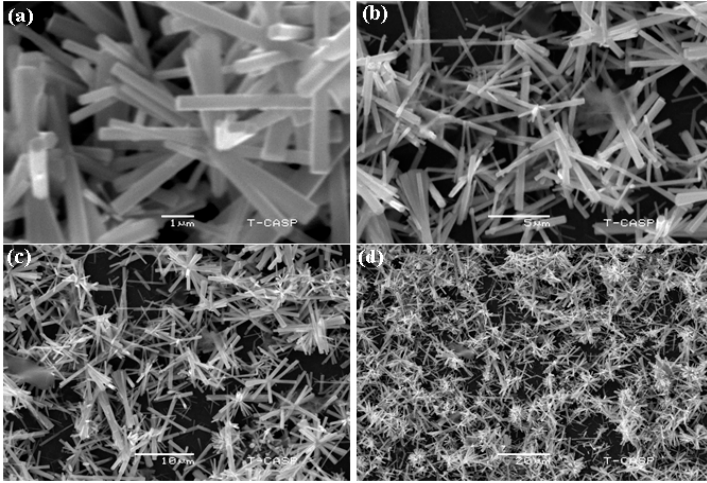
Figure 14. SEM of ZnO nano-rods deposited on the AAO template. ( a ) 1 µm; ( b ) 5 µm; ( c ) 10 µm; ( d ) 20 µm.